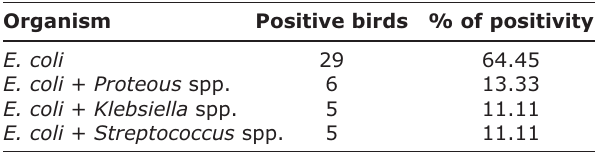
Table-2: Bacterial agents isolated from impacted oviduct of layer chicken.